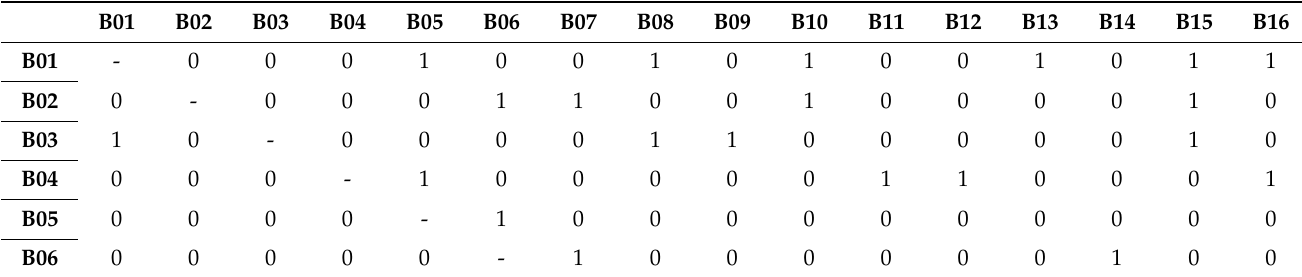
Table 7. The Barrier Relationships